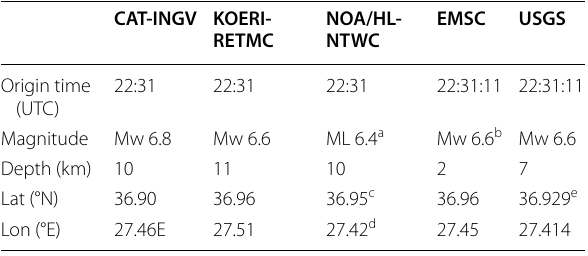
Table 1 Earthquake fault parameters issued in the